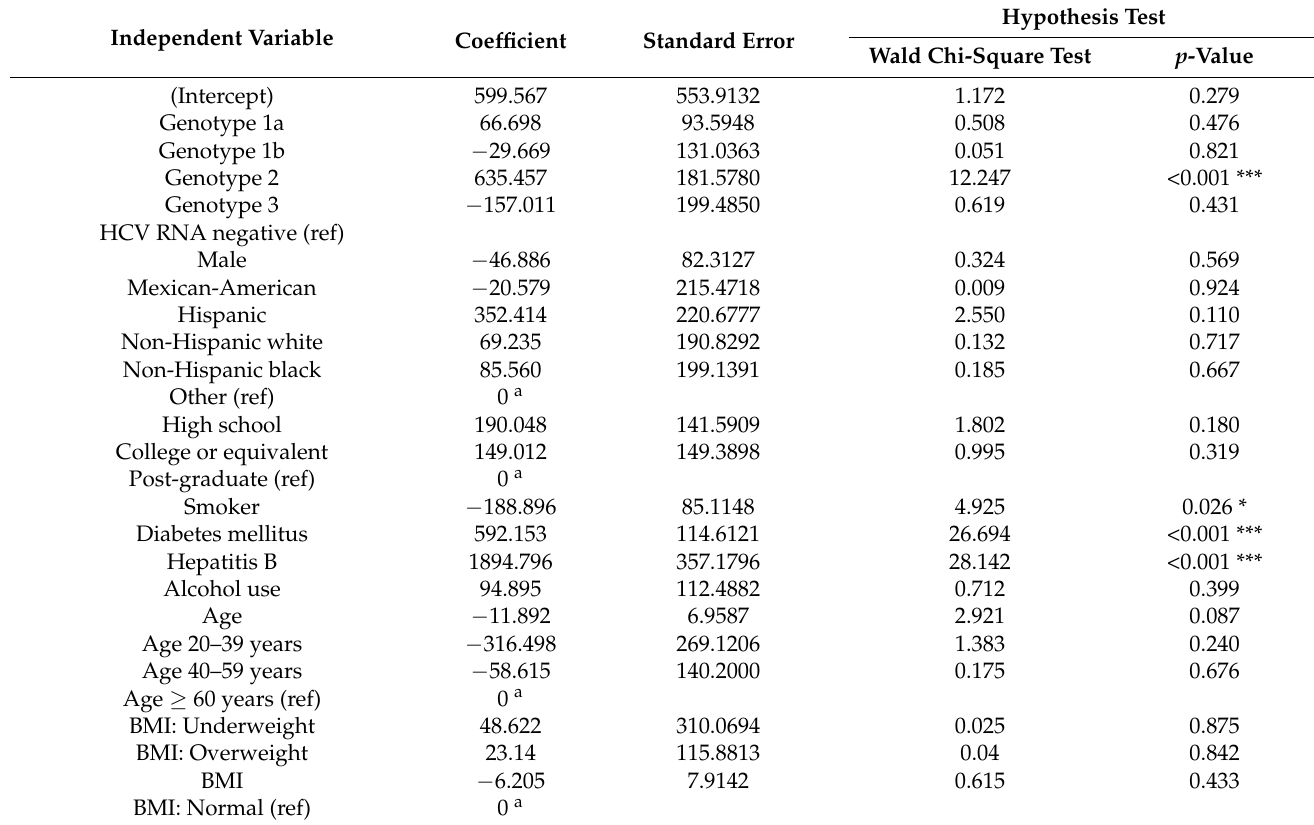
Table 3. Generalized linear equation for HCV genotypes and urine